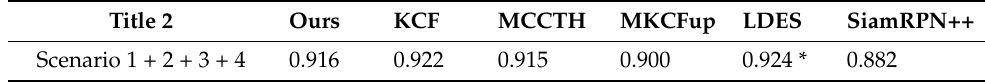
Table 3. Tracking accuracy using Metrics-1.